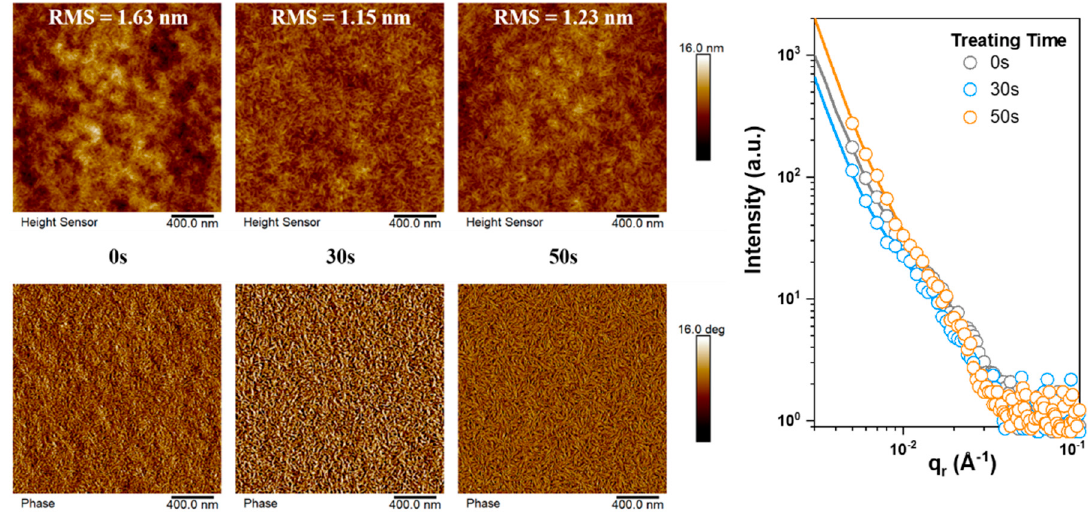
Figure 3. AFM height and phase images, and GISAXS results.